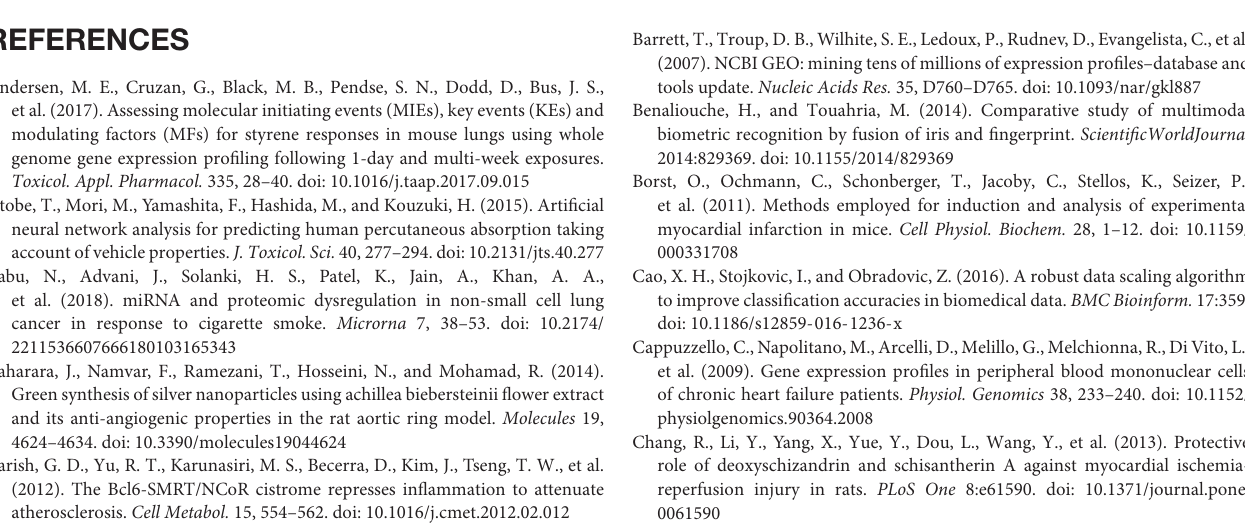
TABLE S2 | Target data simulated through Pharmmapper based on identified Schisandra components. TABLE S3 | Schisandra related pathways enriched through simulated targets. TABLE S4 | AMI related targets collected through datamining. TABLE S5 | Gene ontology terms of AMI related targets. TABLE S6 | Targets related with pharmacological effects. TABLE S7 | Gene ontology terms of AMI pharmacological